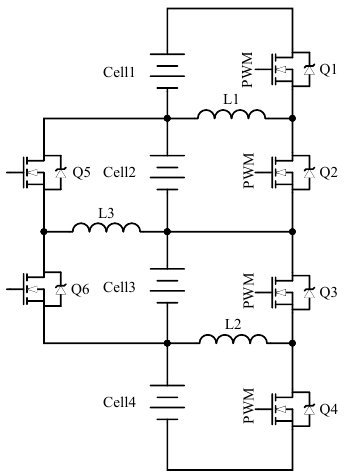
Figure 6. Buck-Boost converter balancing circuit.